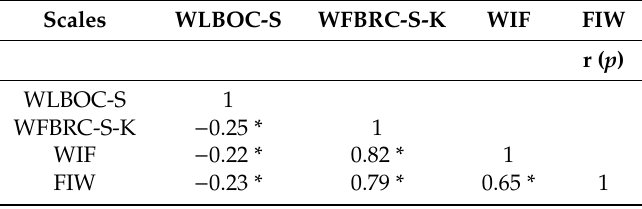
Table 4. Analysis of criterion-related